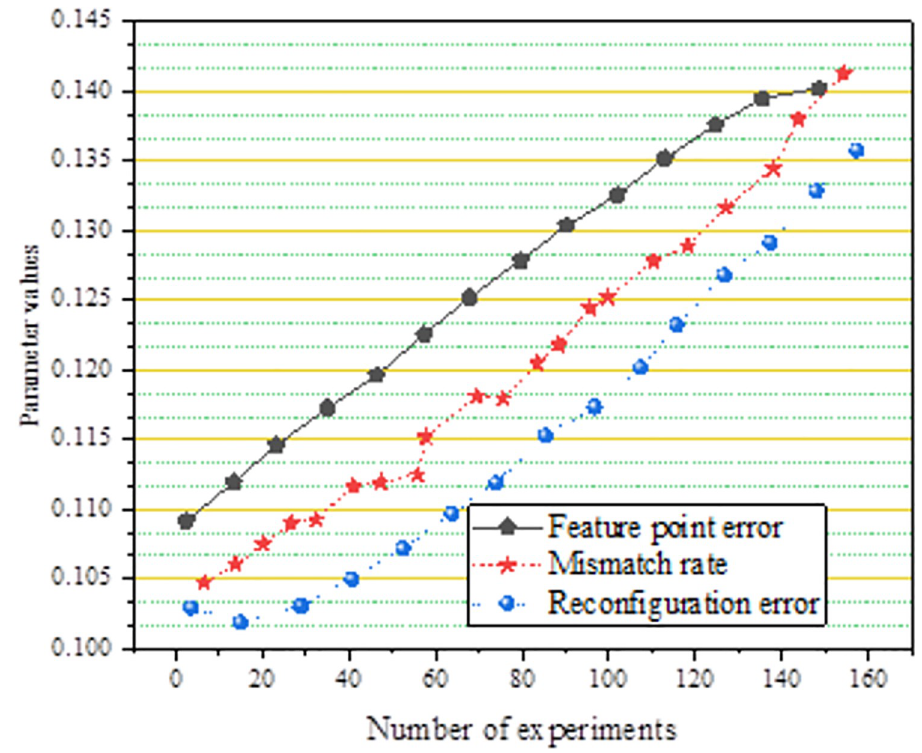
Fig 8. Verification results of the improved